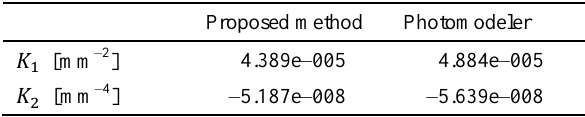
Table 1. Estimated radial components of the distortion